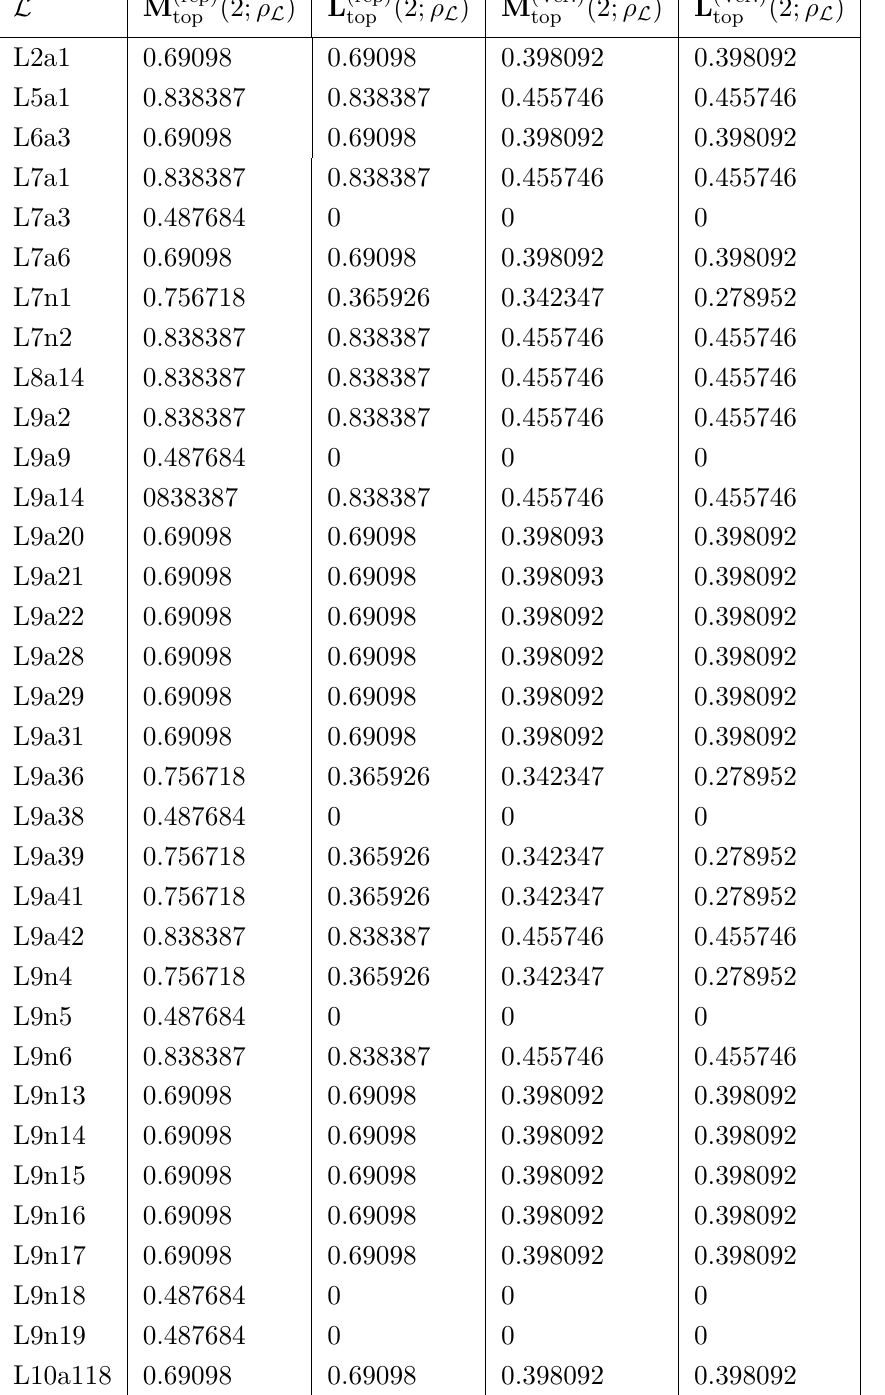
Table 1 . The k = 2 global topological mana and the topological long-range mana for a set of two-links in both the rep and Verlinde bases